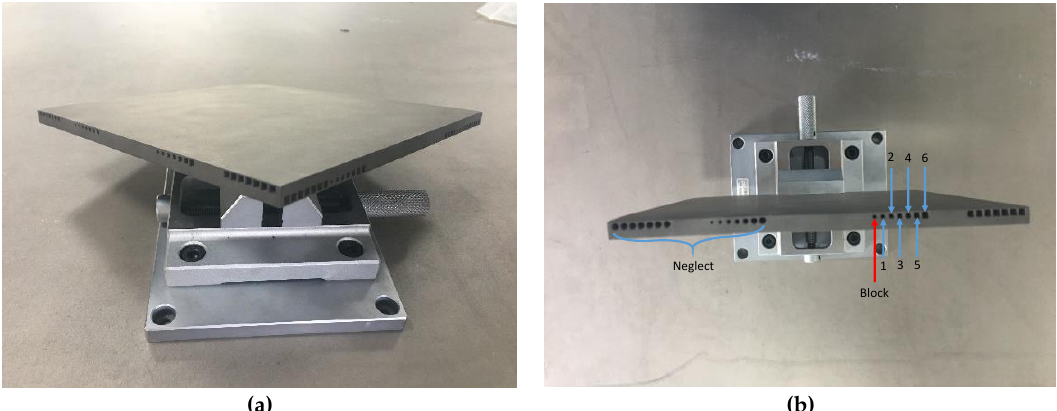
Figure 3. ( a ) The printed specimen and ( b ) the measured position in this work.